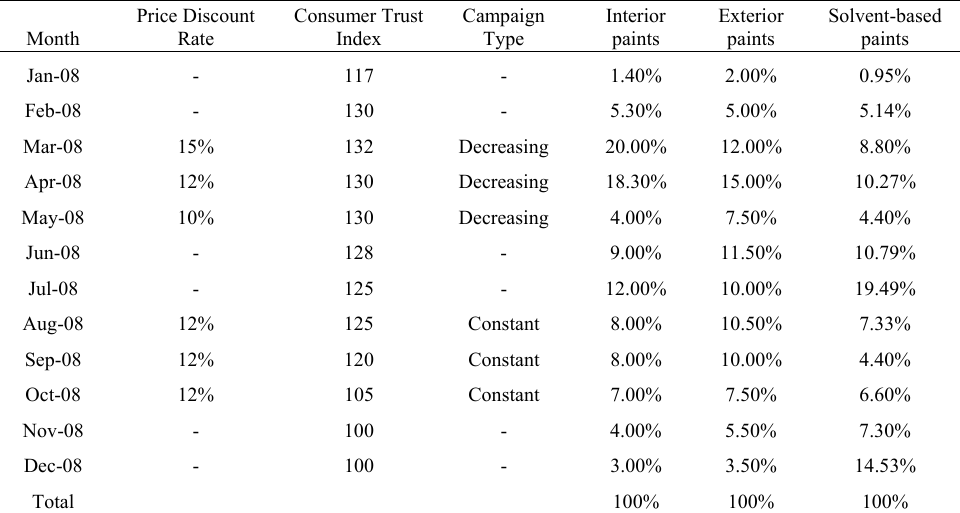
Table 4. Adjusted FRBS outputs for